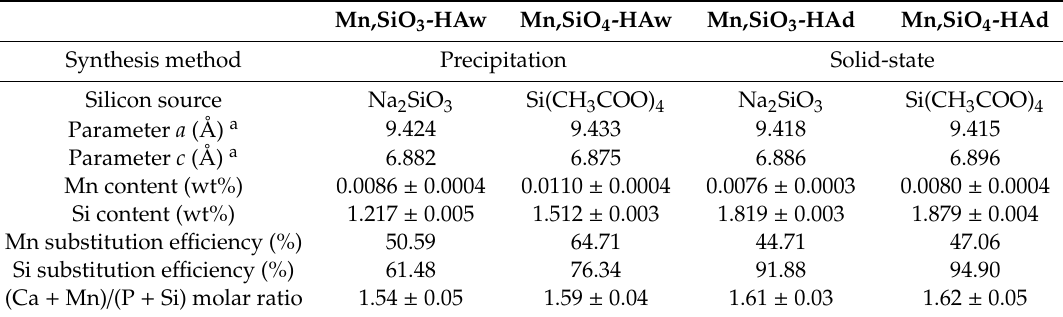
Table 1. Various parameters of the obtained